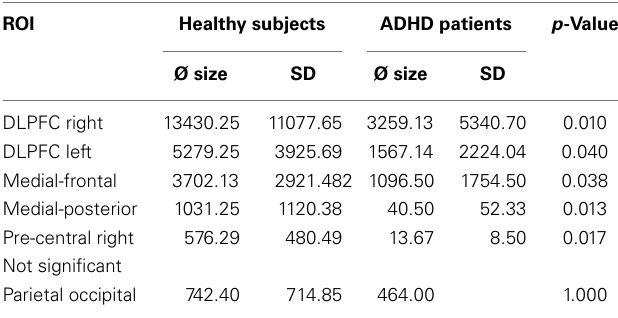
Table 5 | Differences between healthy subjects’ andADHD patients’ BOLD activity in the different